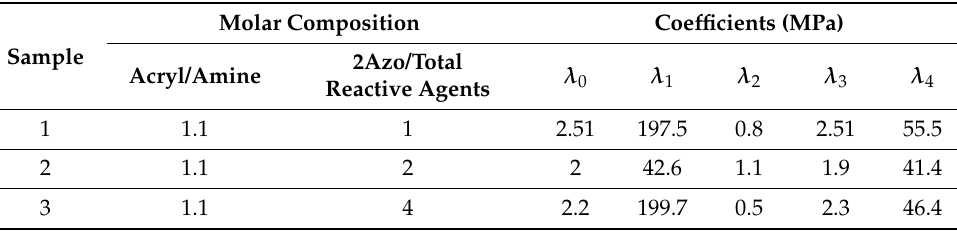
Table 1. Compositions of samples and calculation